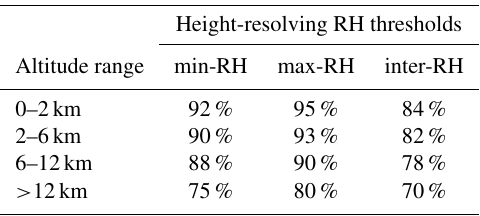
Table 1. Summary of height-resolving RH